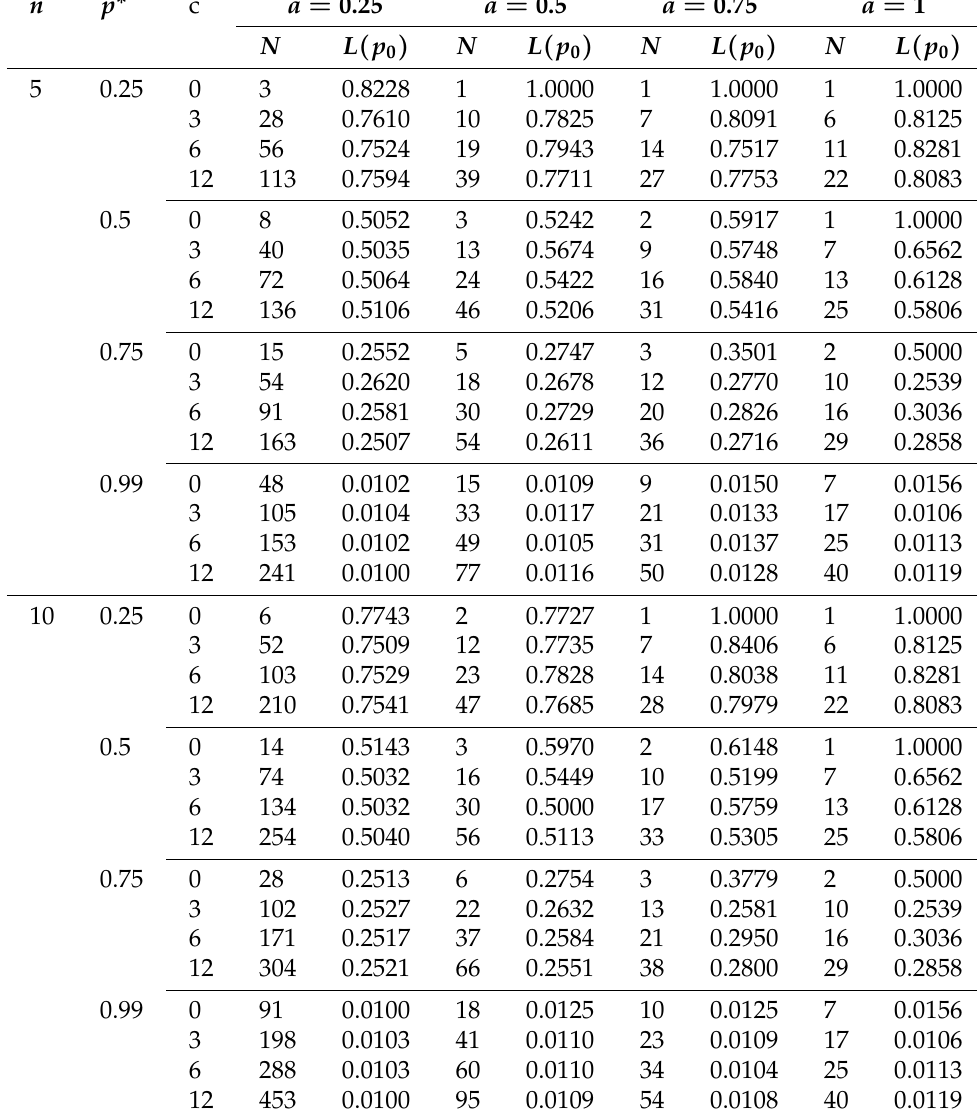
Table 4. Numerical outcomes of a single sampling plan for FB model at combination